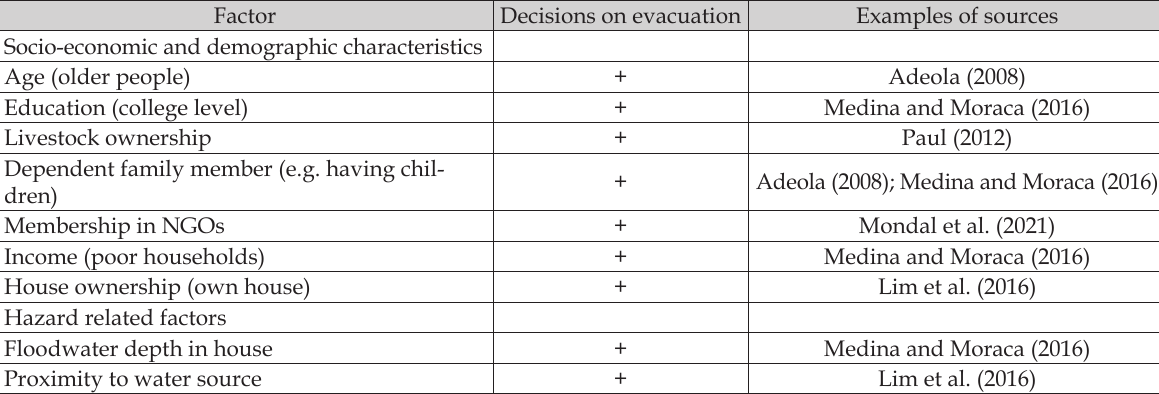
Table 1. Factors affecting evacuation